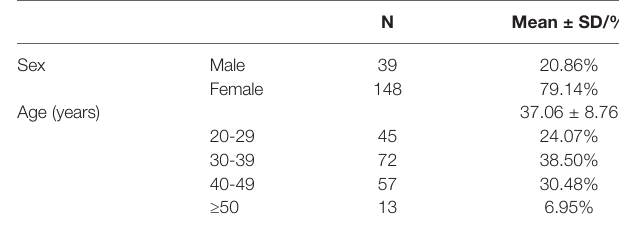
TABLE 1 | Baseline